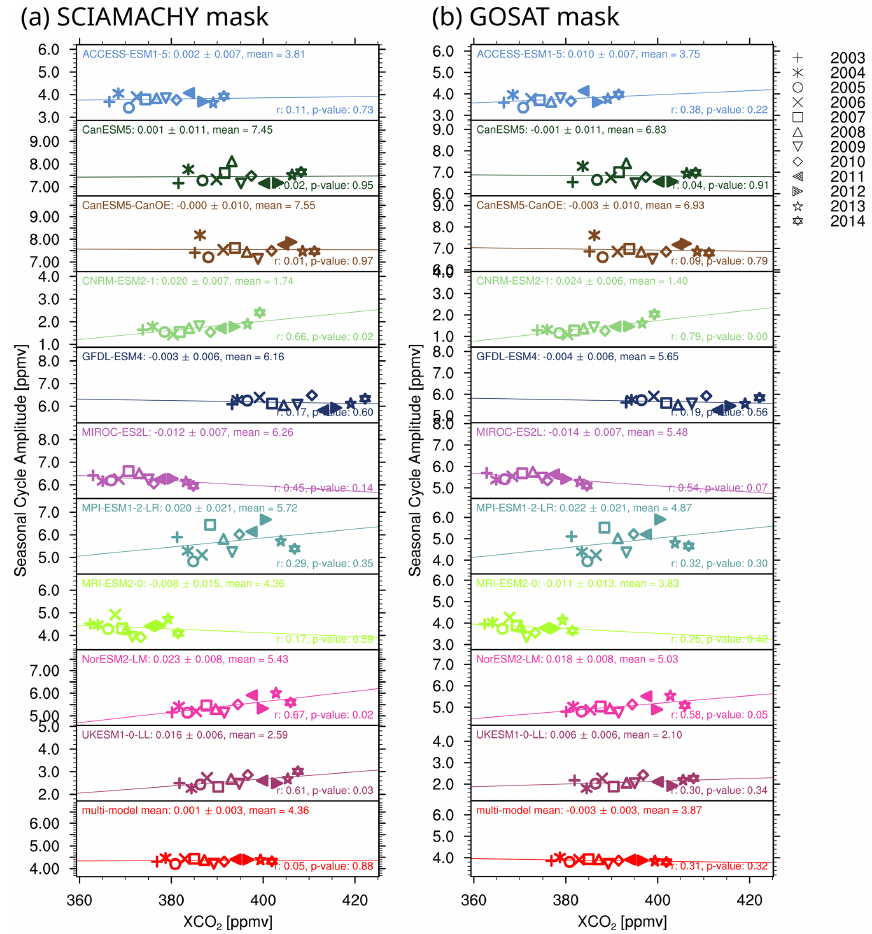
Figure 9. Same as Fig. 7 but with CMIP6 models masked using (a) the SCIAMACHY mask and (b) the GOSAT mask, with the masks derived from Fig. 8, masking out points with less than 50% coverage in those time